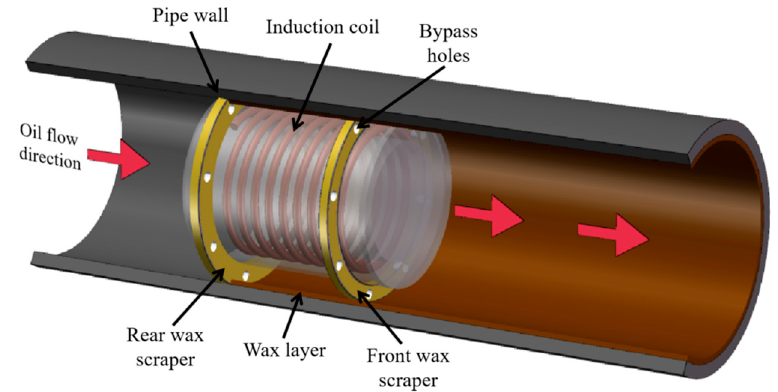
Figure 1. Schematic diagram of the SPM-NP pigging system.